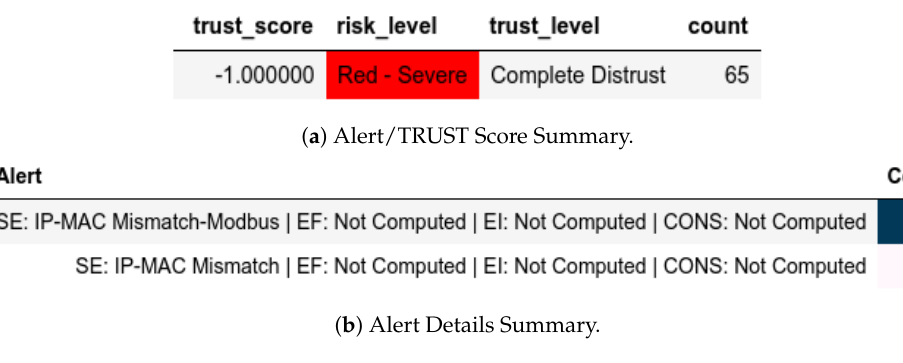
Figure 9. Server: EPM dataset external test- H (cid:48) in CNC capture.